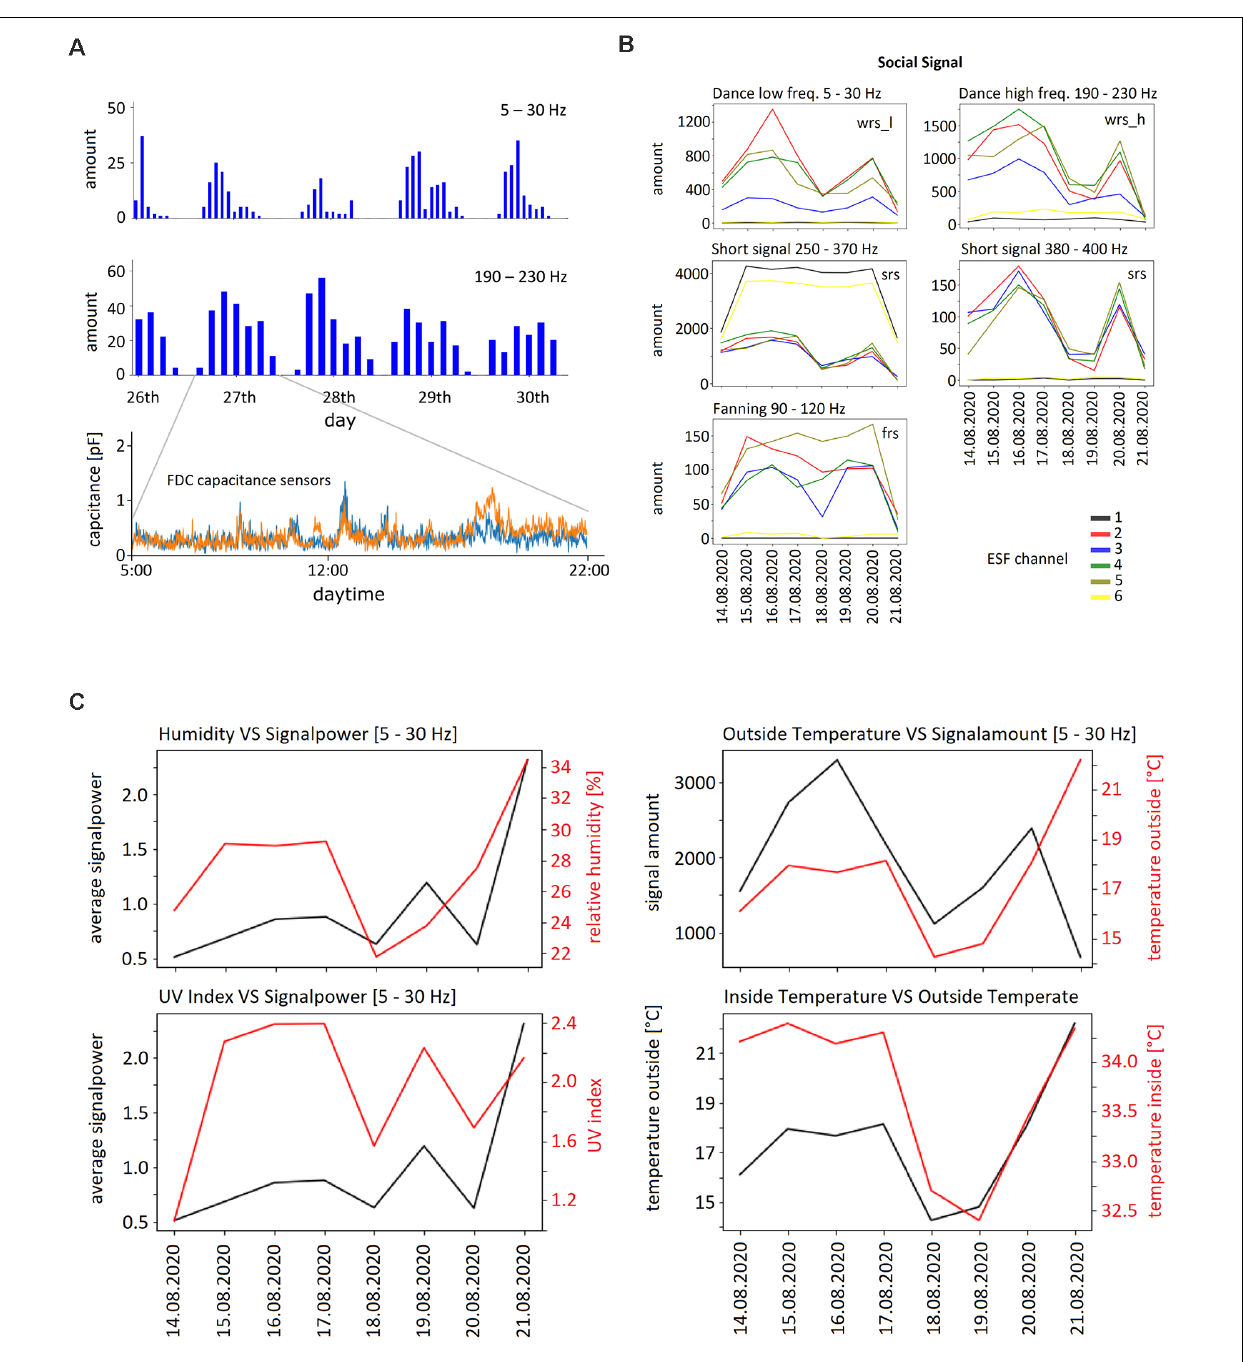
FIGURE 6 | Examples of ESF signals and external as well as internal parameters. (A) Upper two graphs: daily rhythms of waggle dance related signals in both frequency bands (WRS_L, WRS_H) between April 20 and April 26, 2020. The bin width of the upper graph is 1 h, that of the graph below 2 h. Lower graph: signals from the two activity sensors on one day (April 17, 2020). (B) Examples for the five frequency bands of ESF signals recorded between August 14 and August 21, 2020 by the six ESF sensors. WRS_L: waggle dance related signal low frequency band, SRS: short pulse related signal, FRS: fanning related signal. The number of the respective signals per hour were averaged for each day. Notice the different scale of the ordinate. (C) Humidity outside, temperature outside, UV index, temperature inside and signal power during the time period August 14–21, 2020. Note the corresponding ordinates.